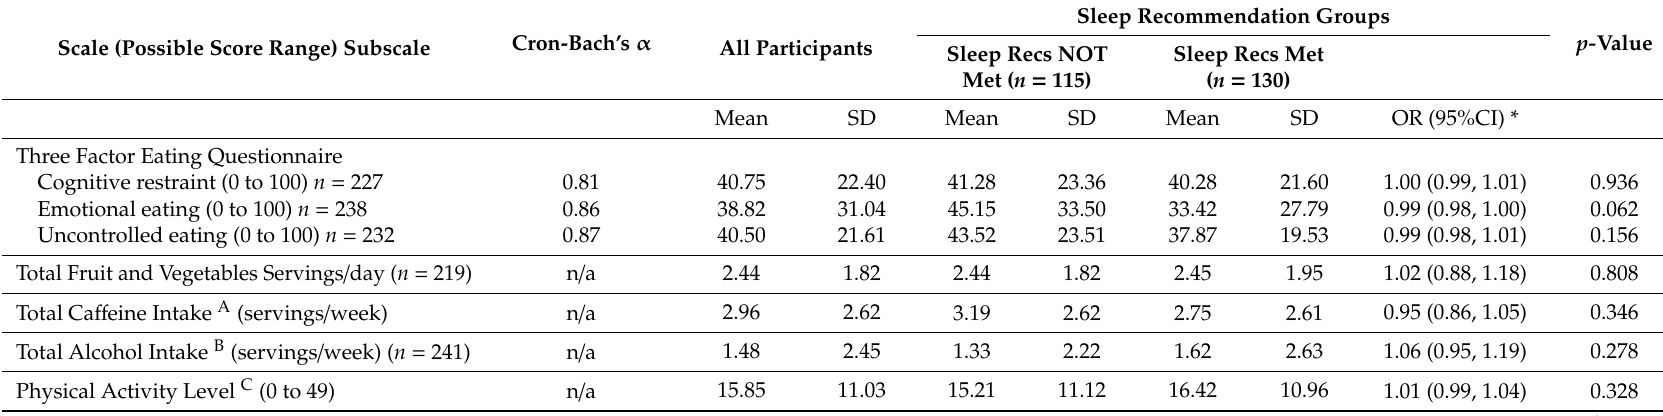
Table 3. Adjusted binary logistic regression of weight-related behaviors by Canadian college student groups that met and did not meet sleep recommendations. N = 245. Scale (Possible Score Range) Subscale Cron-Bach’s α All Participants